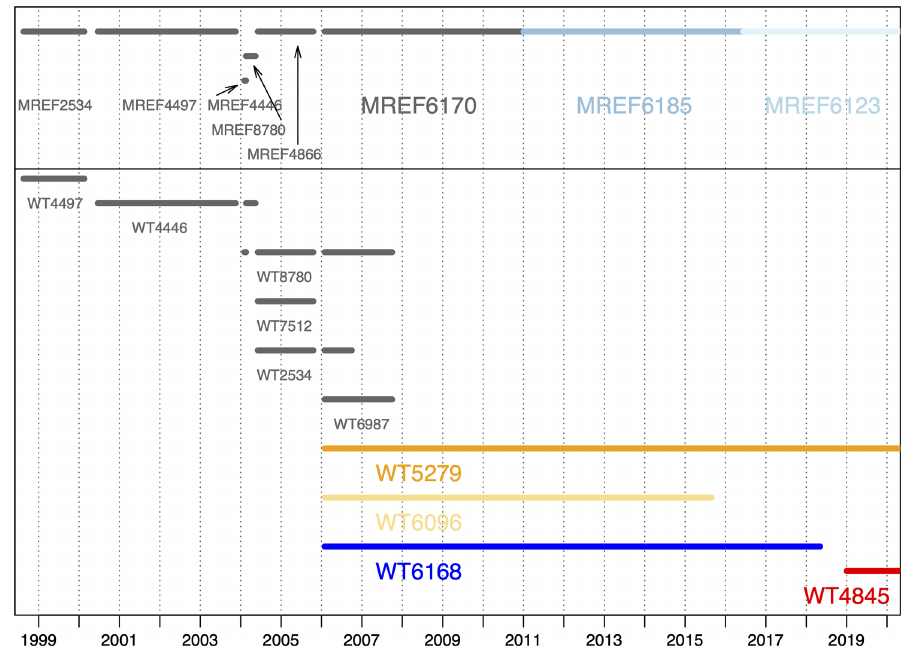
Figure 2. Summary of the different WTs and MREF cylinders in the 1998–2020 period. MREFs are shown along the top, with WTs below. In the case of WTs, there is typically overlap between more than one WT. Periods in grey are adapted from the work of van Der Laan-Luijkx (2010). Table 1. Summary of the calibration periods defined in this paper and the corresponding MREF cylinder and WT cylinder numbers most recently used for the calibration of the DI-IRMS. The greyed-out rows are the cylinders used prior to this work, but are included here to demonstrate a complete